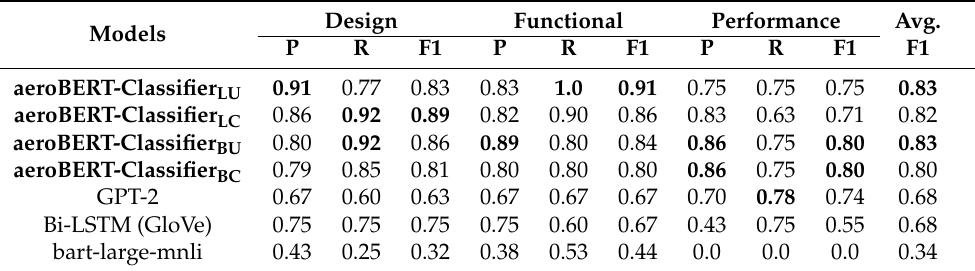
Table 9. Requirements classification results on aerospace requirements dataset. The highest score for each metric per class is shown in bold . (P = Precision, R = Recall, F1 = F1 Score).